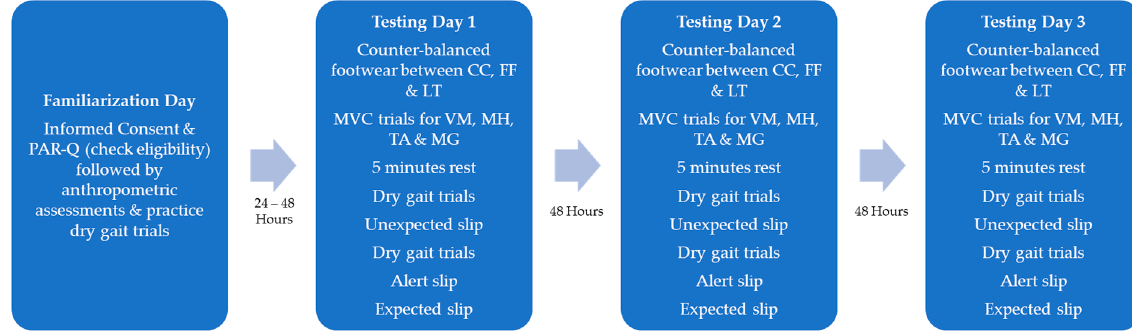
Figure 3. Testing protocol for three footwear types: Crocs (CC), flip-flops (FF), and low-top slip resistant shoe (LT) for four lower extremity muscles: vastus medialis (VM), medial hamstrings (MH), tibialis anterior (TA), and medial gastrocnemius (MG).